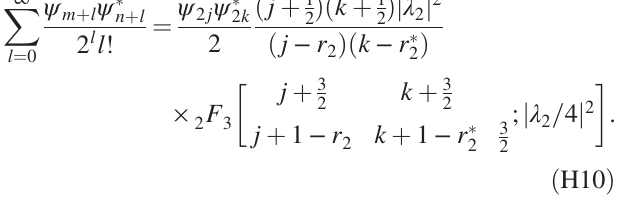
[cf. Eq. (H5)] with o